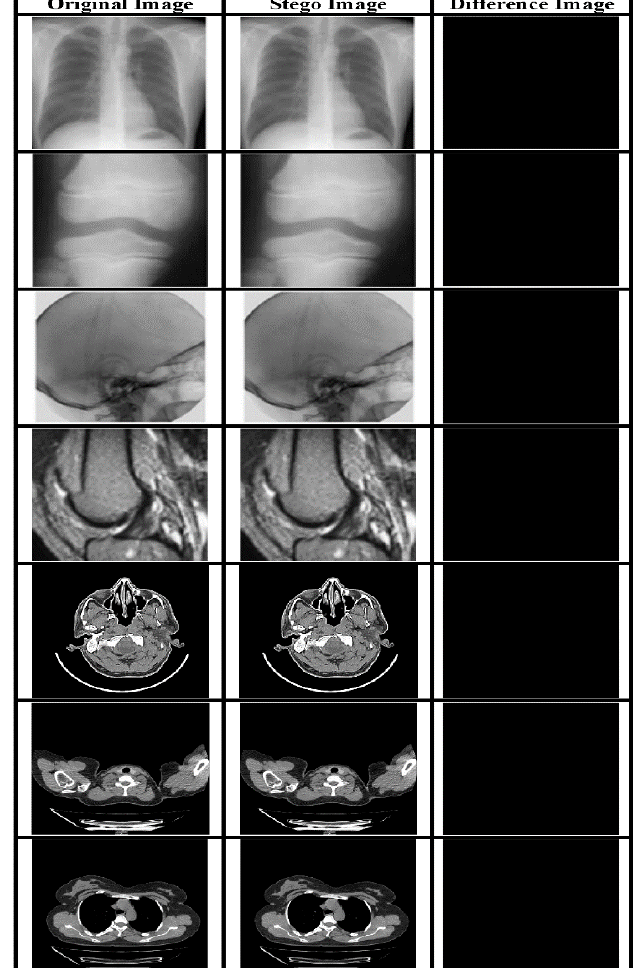
Figure 5. MI with their corresponding SI for a payload of 0.75 bpp and the subtracted image.